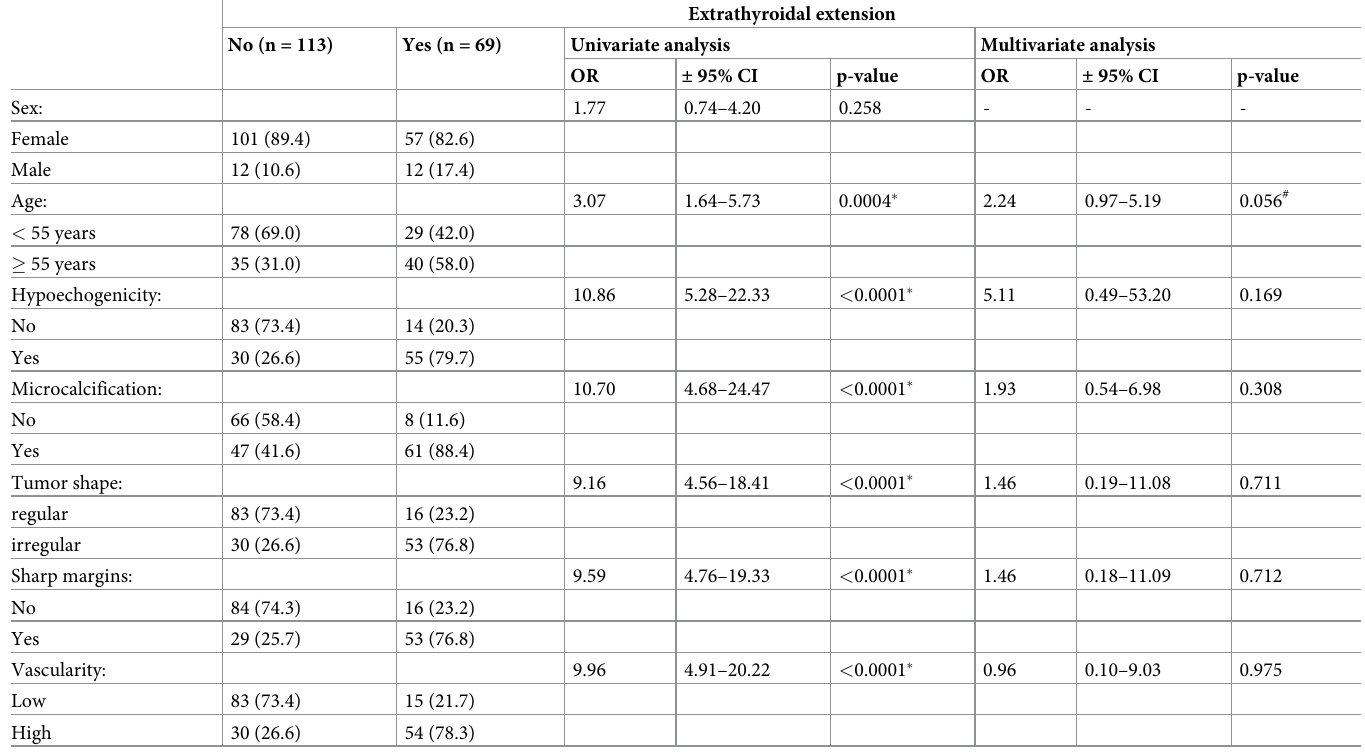
Table 2. Univariate and multivariate logistic regression analysis of demographic and ultrasound features as risk factors for minETE in PTMC